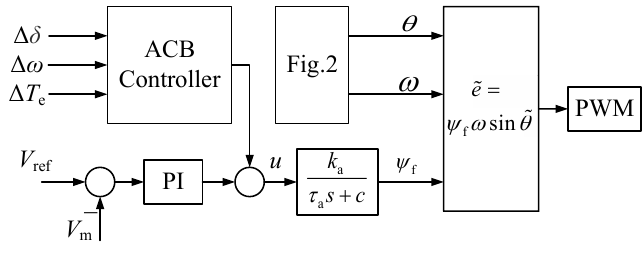
Figure 4. Structure of